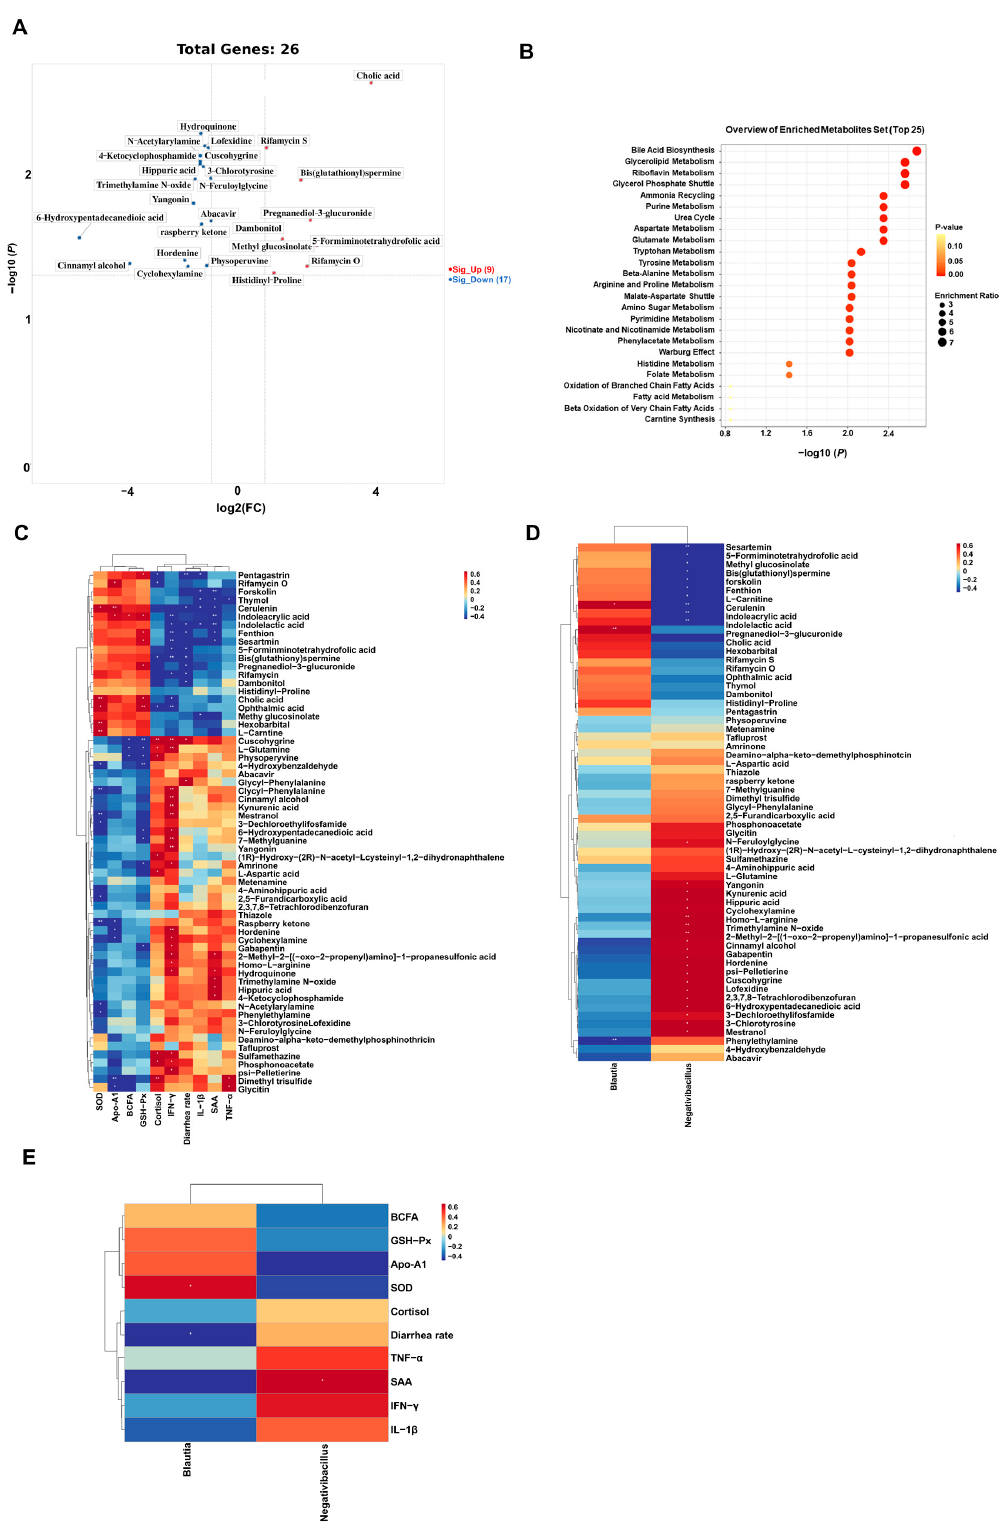
Figure 6. Serum metabolic profiles of cats, and Spearman’s correlation analysis. Volcano plot ( A ), KEGG metabolic pathways enrichment analysis ( B ), heatmaps of Spearman’s correlation analysis between ( C ) differential serum metabolites and serum/fecal parameters, ( D ) differential serum metabolites and fecal microbiota, ( E ) differential fecal microbiota and serum/fecal parameters. Red and blue boxes represent positive and negative